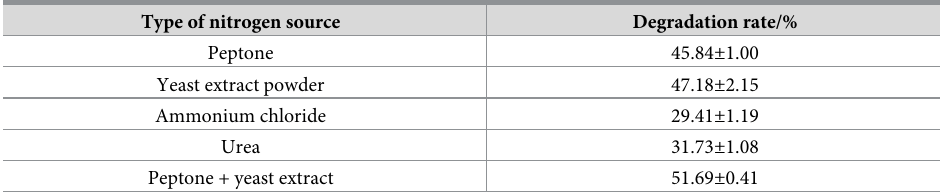
Table 3. Effect of nitrogen sources on the degradation ability of